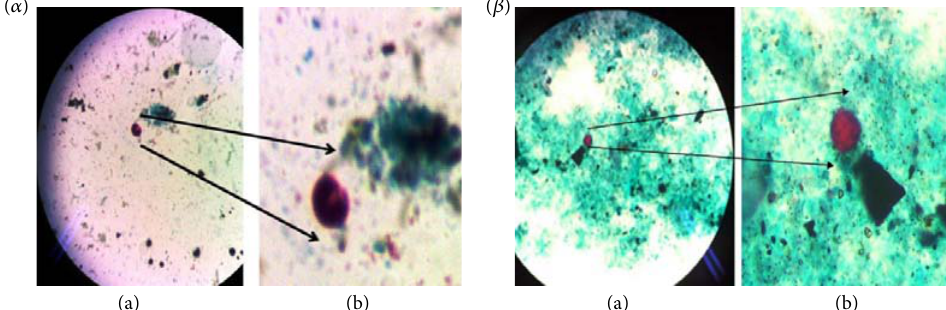
Figure 1: Modified ZN stained slides of parasites identified. (𝛼) Oocysts of Cyclospora cayetanensis . (𝛽) Oocyst of Cryptosporidium parvum . (a) represents magnification of × 1000 while (b) is a zoom-in of the oocyst.